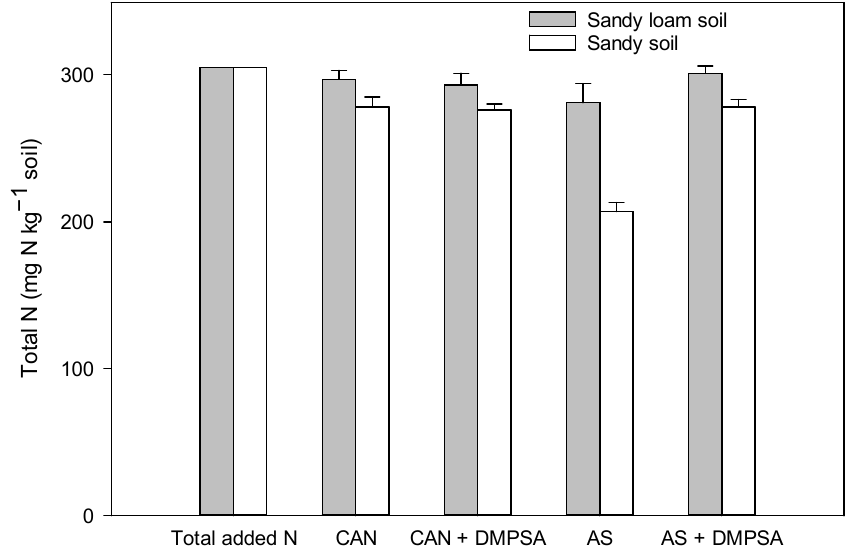
Figure 3. Total mineral N (NH 4+ and NO 3 − ) available in the sandy loam and sandy soil on day 80 (last sampling day). Total added N (added as fertiliser N) is presented in the first bar. Values presented are net of mineralisation in the control treatment over the incubation study. Error bars represent the mean ± 1 SE ( n = 4).